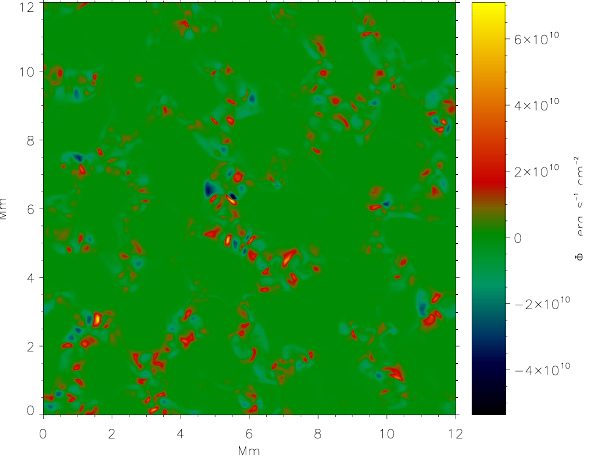
Fig. 4. Dependence of vertical component of the Poynting flux vec- tor, measured in the upper photosphere, on the simulation